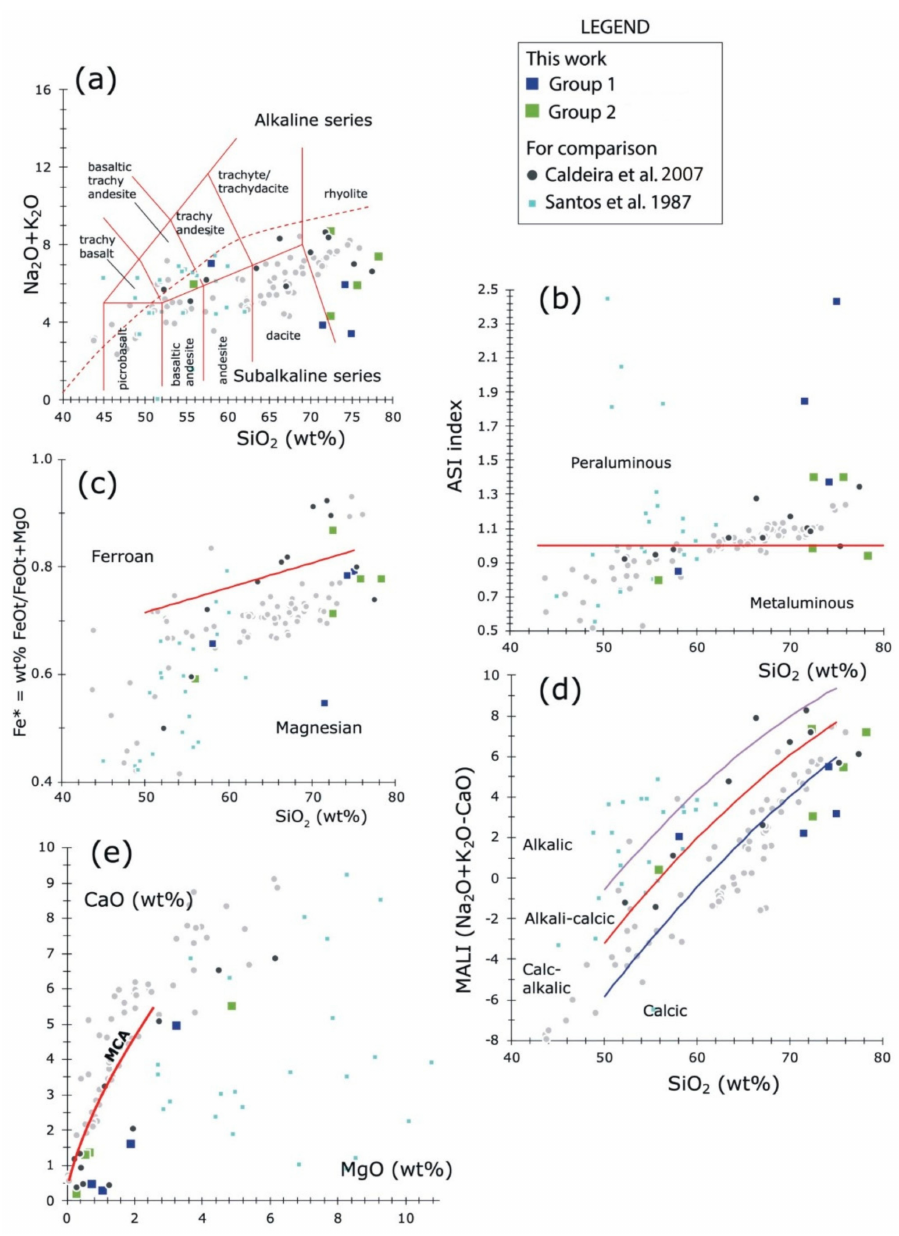
Figure 3. Main geochemical classification diagrams for the Toca da Moura (Group 1) and Baleiz ã o-Alc á çovas (Group 2) igneous rocks. Grey dots represent the É vora gneiss dome plutonic rocks [18,24,25,27]. ( a ) TAS diagram shows the subalkaline character of these rocks. Alumina sat- uration index (ASI); ( b ) and the Fe number ( c ) becomes greater as the silica content increases. ( d ) Modified alkali-lime index (MALI) vs SiO 2 diagram indicates the alkali-calcic and calcic trends of the samples. ( e ) CaO vs. MgO diagram shows the departing of the Toca da Moura and Baleiz ã o- Alc á çovas igneous rocks from the Main Cotectic Array